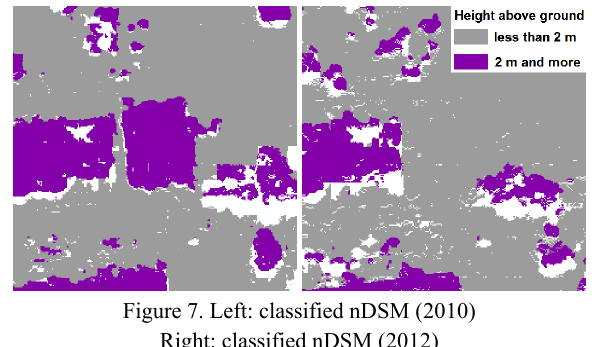
Figure 7. Left: classified nDSM (2010) Right: classified nDSM (2012)